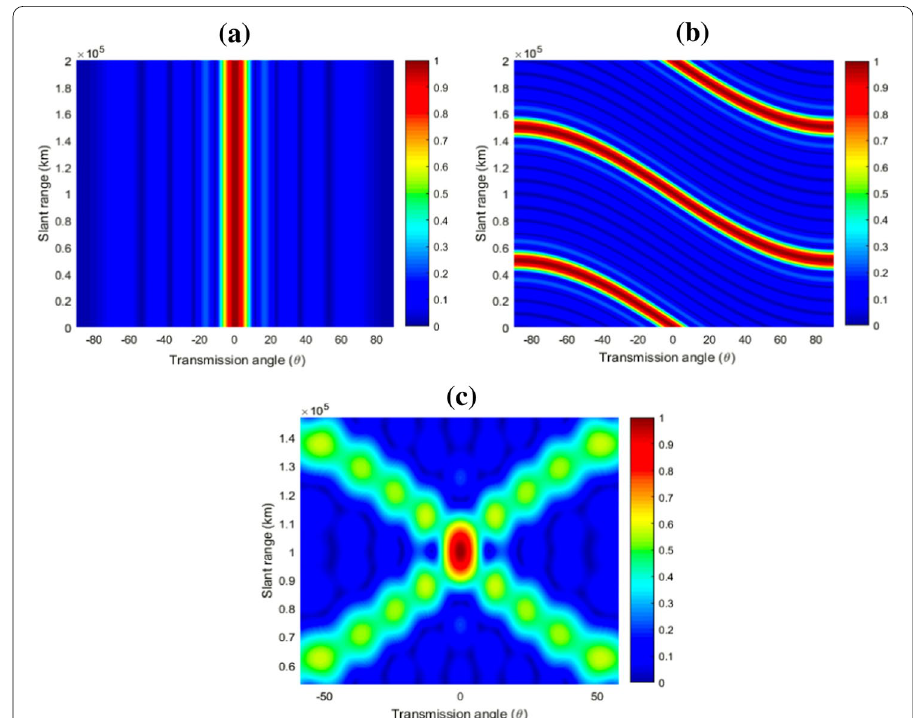
Fig. 5 Comparison of transmit beampatterns. a Phased array. b Standard FDA. c Symmetrical